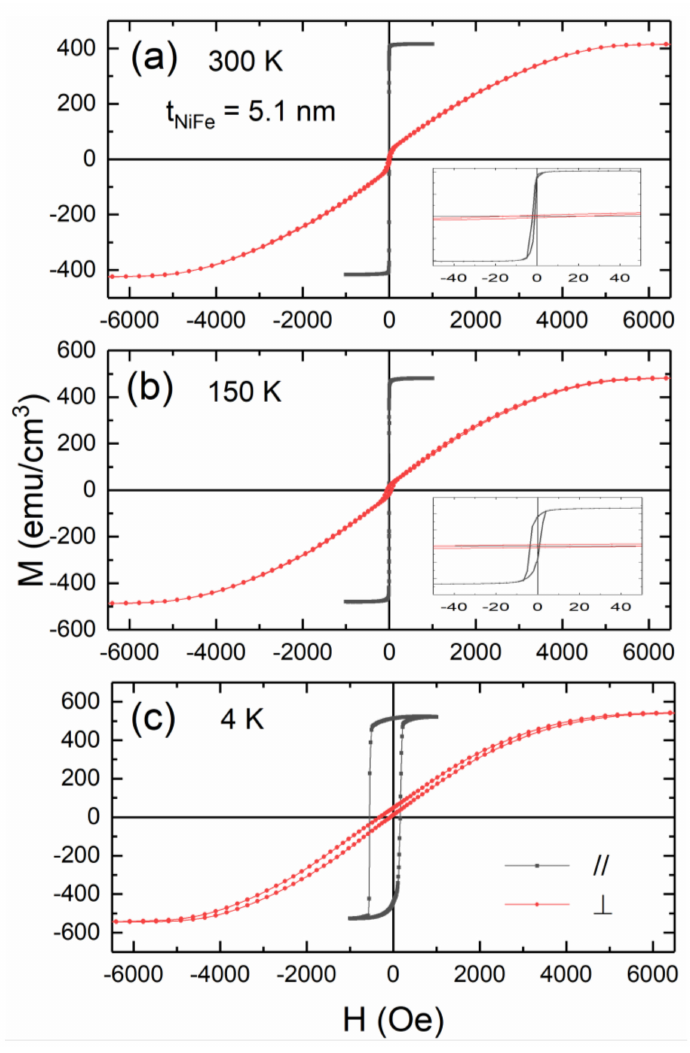
Figure 6. Temperature-dependent magnetization hysteresis loops with the external field applied perpendicular (red circles) and parallel (black circles) to the film plane for a NiFe/NiFeO multilayer with t NiFe = 5.1 nm and 6 repetitions for 300 K ( a ), 150 K ( b ) and 4 K ( c ). The inset in Figure 6 is a magnified plot near zero field for better